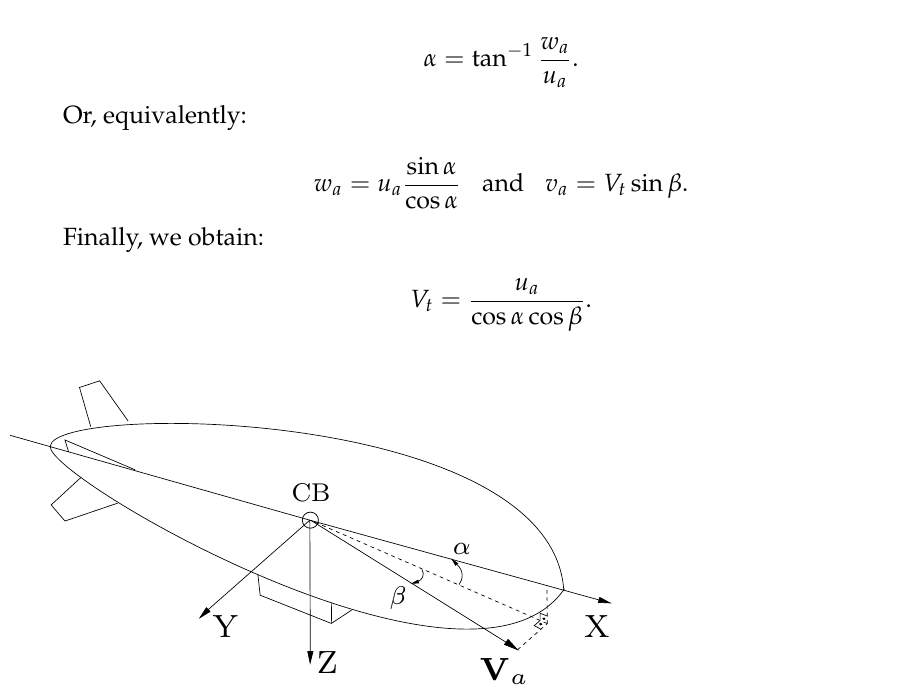
Figure 4. Sideslip angle ( β ) and angle of attack ( α